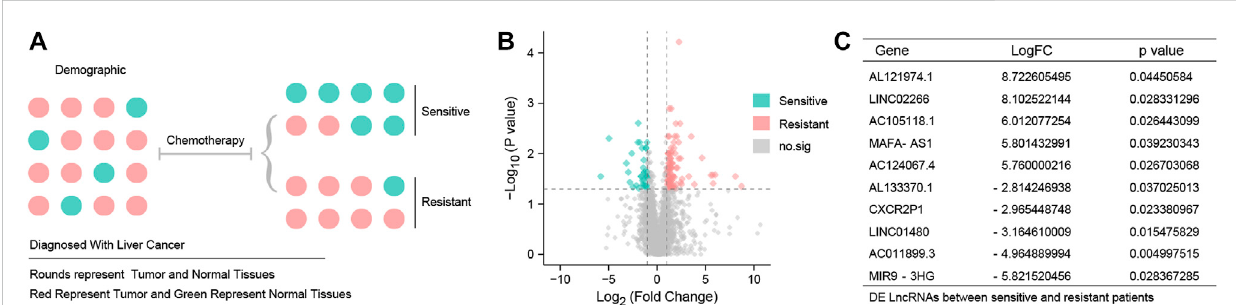
Different expression LncRNAs between resistant and sensitive patients (A) TCGA-HCC patients were grouped according to chemotherapy sensitivity. Red represents tumor patients and green represents normal subjects. (B) Volcano map of 125 DE LncRNAs. Red point represents 88 up-DE LncRNAs, green pointrepresents37down-DE LncRNAs,and graypoint represents DELncRNAswith nostatisticalsigni fi cance.The threshold issettolog fold change (FC) values > 1 and p < 0.05. (C) 10 DELncRNAswith themost signi fi cant fold change were AL121974.1, LINC02266, AC105118.1,MAFA-